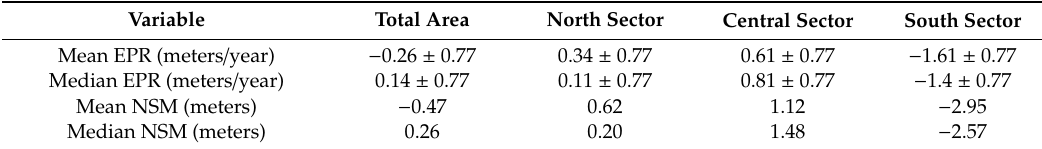
Table 5. Evolution rates between 2008 and 2010.